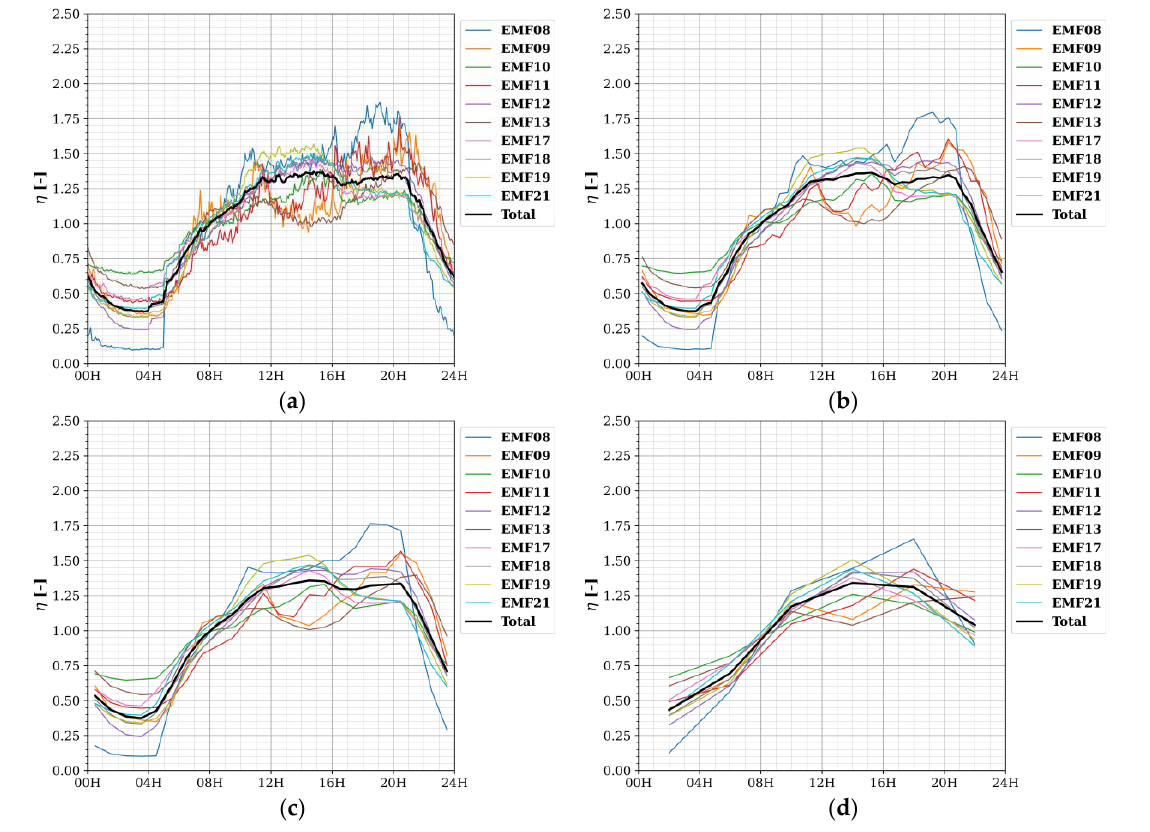
Figure 9. Diurnal temporal profiles for 1800 MHz with ( a ) Δ t = 5 min, ( b ) Δ t = 30 min, ( c ) Δ t = 1 h, and ( d ) Δ t = 4 h.